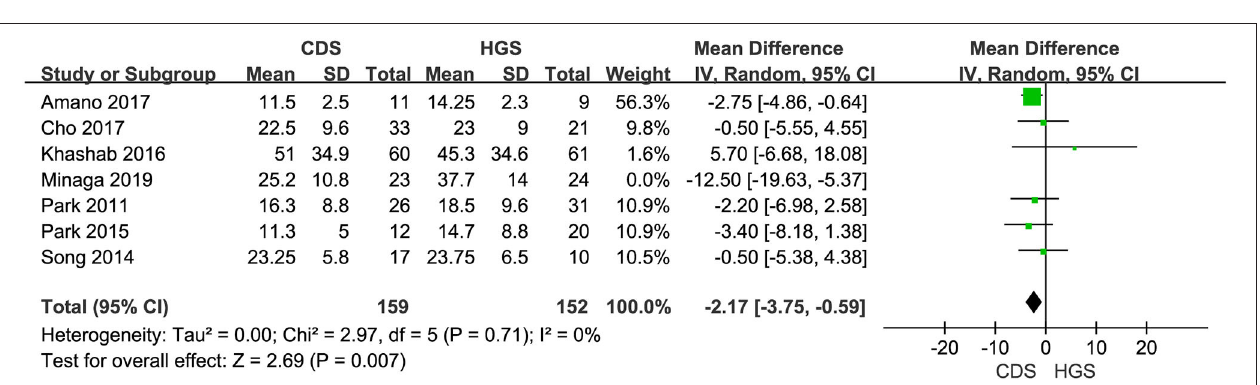
the patient’s anatomy, the underlying disease (benign/malignant), the location of the obstruction (distal/hilar), and operator expertise